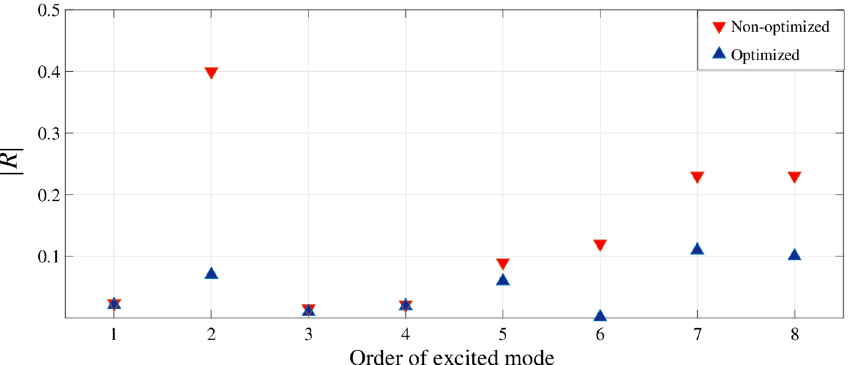
Figure 12. Reflection in each excited mode.